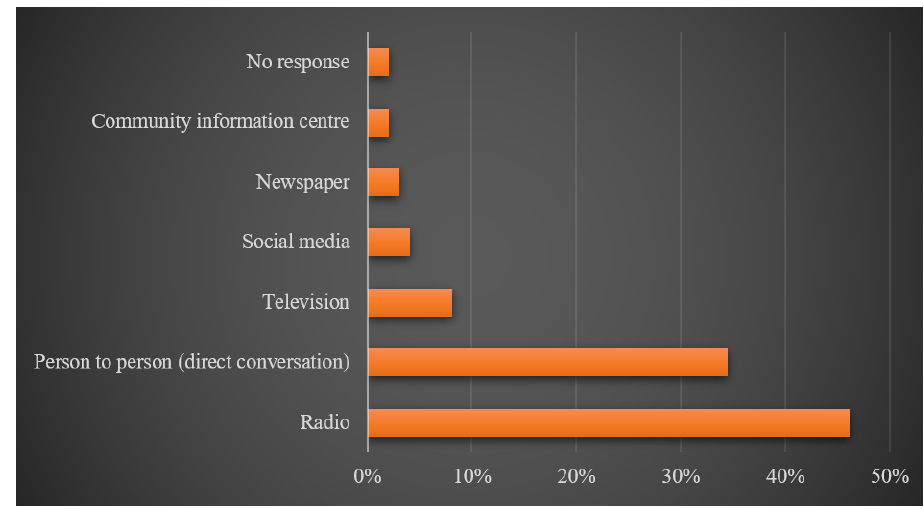
Figure 2. Source of information of respondents on proposed mining of the forest reserve. Source: Field survey, 2021.